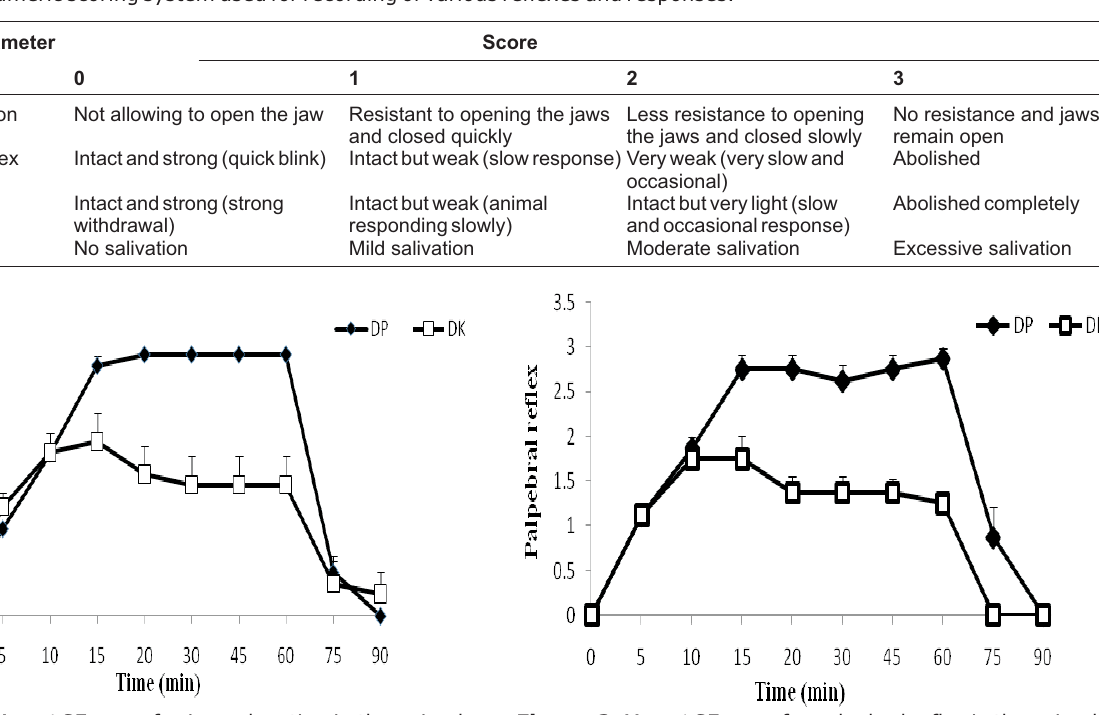
Figure-2: Mean±SE score for palpebral reflex in the animals of groups DP and DK at different time